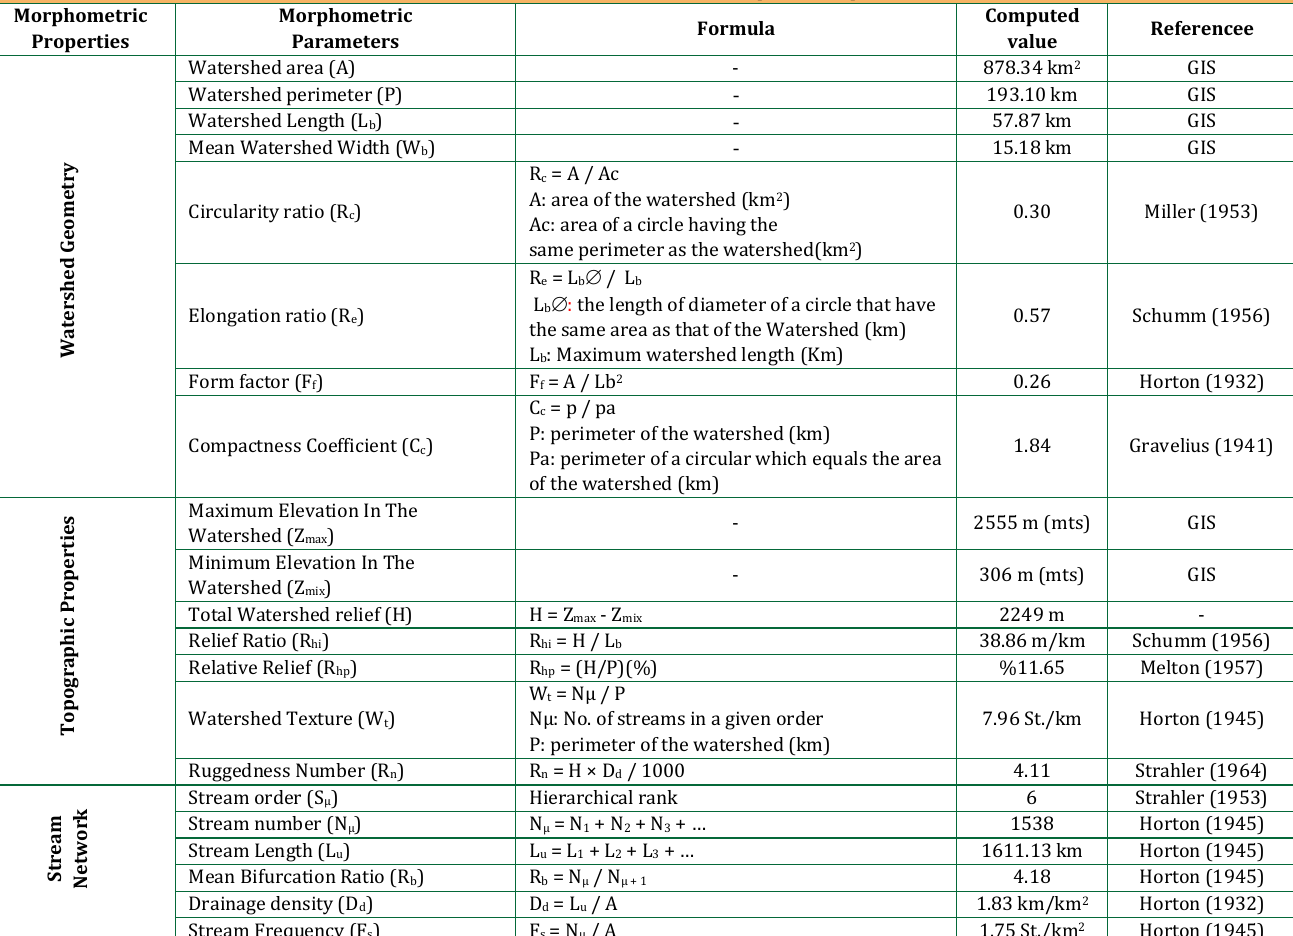
Table 1: Mathematical and statistical methods used in evaluation of morphometric parameters of Abbasan watershed